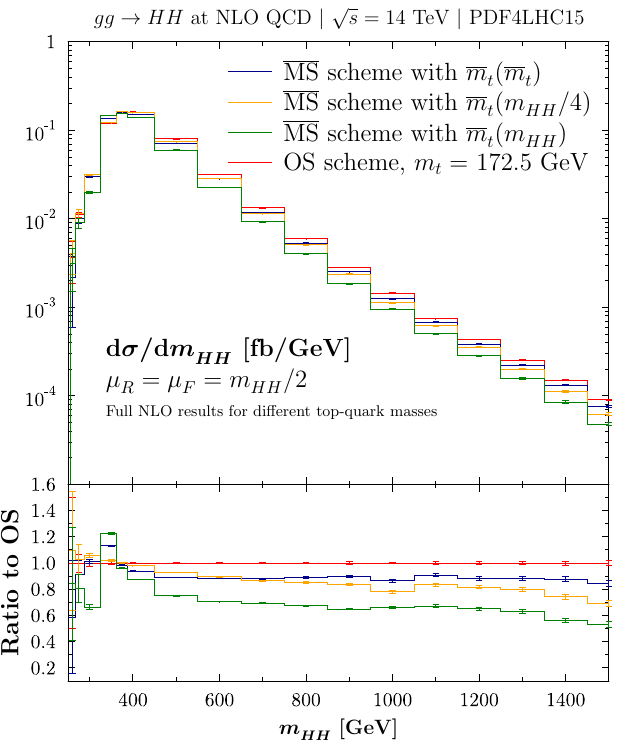
Figure 14 . The di(cid:11)erential Higgs-pair production cross section at NLO as a function of the invariant Higgs-pair mass for a c.m. energy of 14 TeV for four di(cid:11)erent choices of the scheme and scale of the top mass. The lower panel shows the ratio of all results to the default results with the top pole mass (OS scheme). PDF4LHC PDFs have been used and the renormalization and factorization scales of (cid:11) s and the PDFs have been (cid:12)xed at our central scale choice (cid:22) R = (cid:22) F = Q=